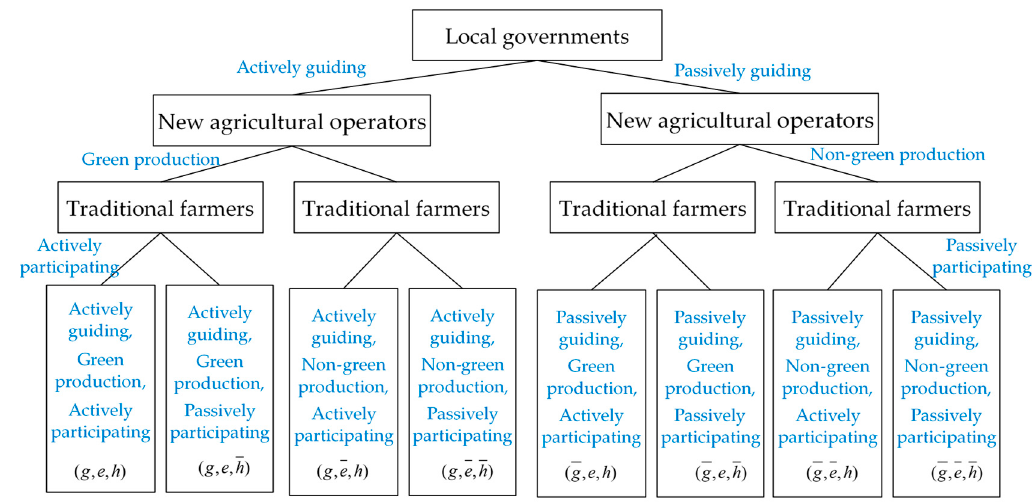
Figure 1. Tripartite game strategies.